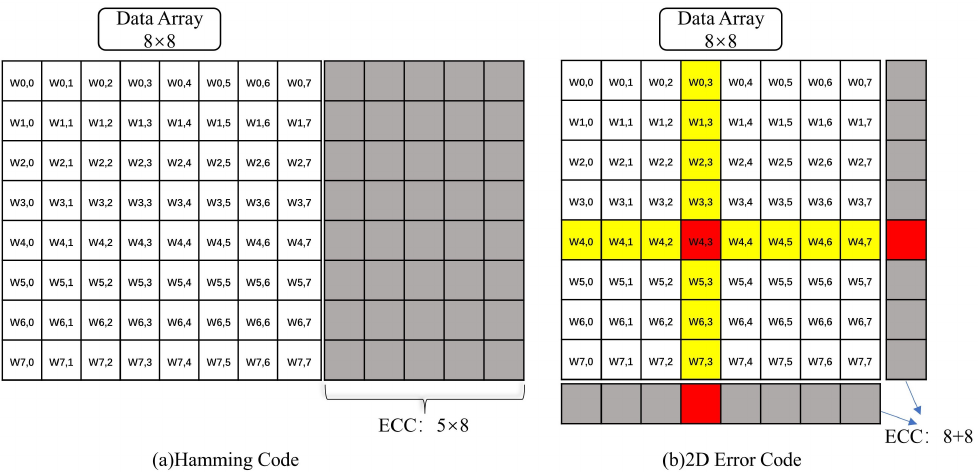
Figure 1. Error Coverage and Area Overhead for Traditional Hamming Codes and Two-Dimensional Error Coding in an 8 × 8 SRAM